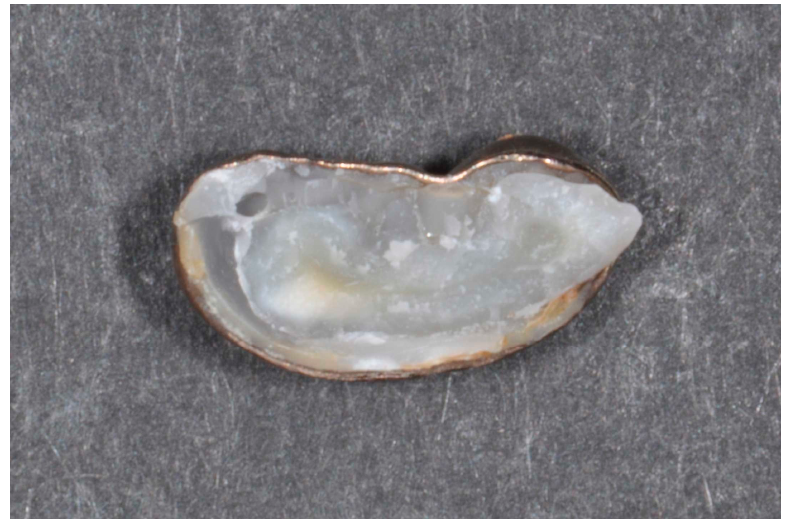
Coatings 2021 , 11 , x FOR PEER REVIEW Figure 4. Fracture of both lingual cusps during debonding. Figure 4. Fracture of both lingual cusps during debonding.